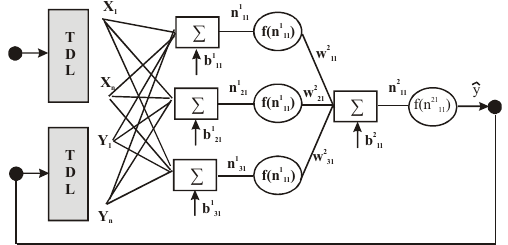
Fig. 1. Chosen structures of the NARX network: closed-loop.